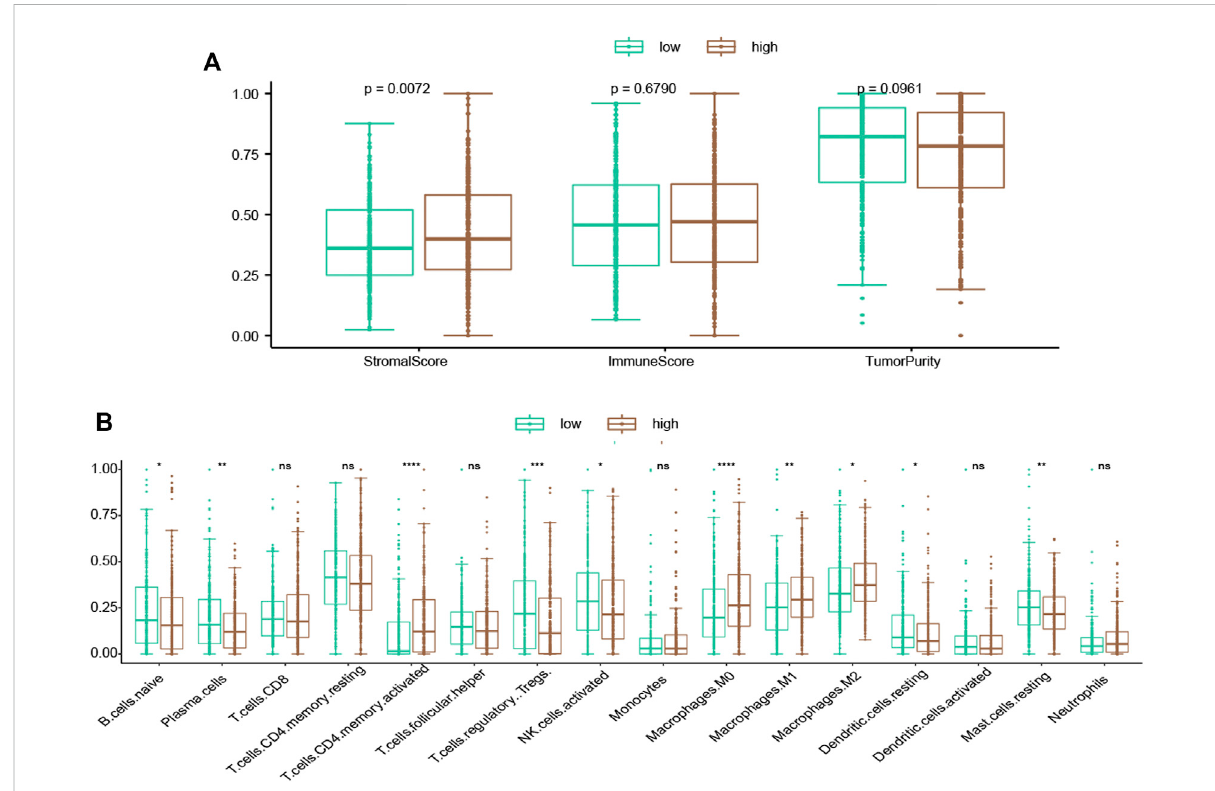
FIGURE 7 Evaluation of the association of TME compositions with the risk score. (A) Inside the high-risk group, the stromal score was greater. (B) In fl ammatory cells in fi ltrating ratios in risk groups. */**/****: statistically signi fi cant.